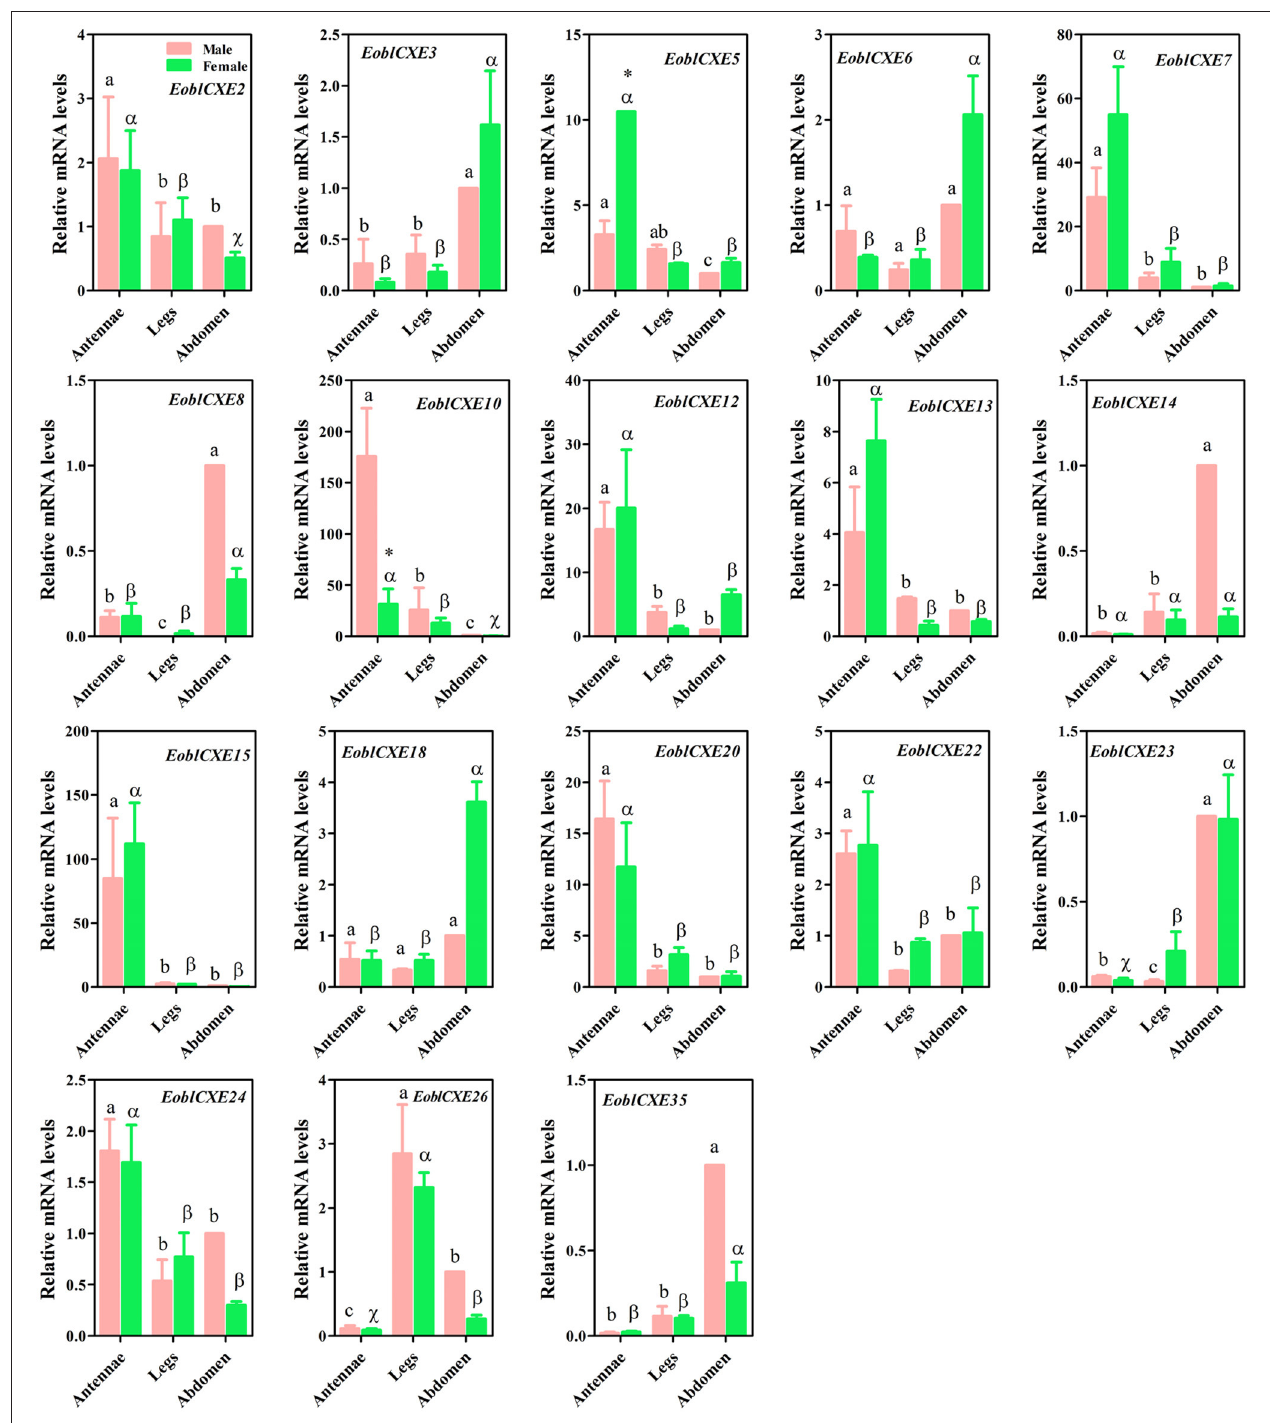
FIGURE 3 | Relative mRNA levels of EoblCXE genes in different tissues of male and female E. obliqua adults, as revealed via qRT-PCR. The reference gene EoblGAPDH was found to be expressed at a similar level in different tissues and was employed as an internal control to normalize target gene expression in order to correct for sample-to-sample variation (Sun et al., 2017a). The amplification efficiency for the target and reference genes were assessed using gradient dilution templates to examine the variation of 1 C T (C T, Target gene − C T, reference gene ) with template dilution (Livak and Schmittgen, 2001). The absolute values of the slopes of all lines from the template dilution plots (log cDNA dilution vs. 1 C T ) were close to zero, indicating that the efficiency for EoblCXEs was similar to that for EoblGAPDH . The fold changes are relative to the transcript levels in the male abdomen. The error bars represent the standard error, and different letters (a, b and c for male; α , ß, and χ for females) above each bar denote significant differences ( P < 0.05). The t and p -values in Student’s t -test are shown in Table S5 and the asterisk indicates significantly different relative expression levels between male and female antennae.